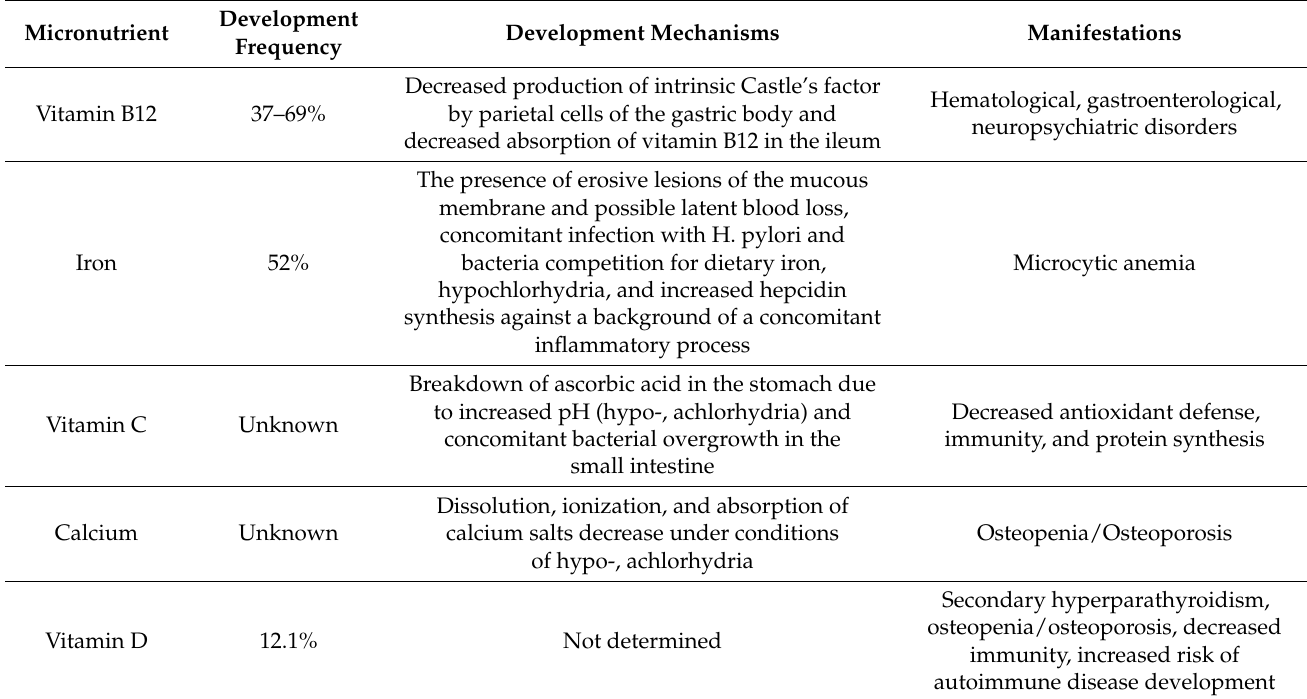
Table 2. Micronutrient deficiency in autoimmune gastritis: prevalence, development mechanisms, clinical manifestations (adapted from Cavalcoli et al.,